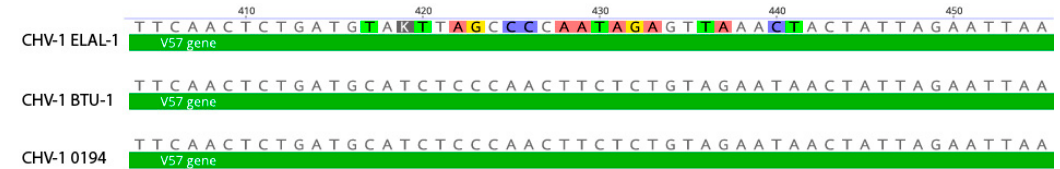
Figure 4. Variant in CHV-1 ELAL-1 isolate in the V57 gene region. A clearly identifiable region of low identity was detected centered around position 430 in the V57 gene which corresponded to a novel variant in CHV-1 ELAL-1.